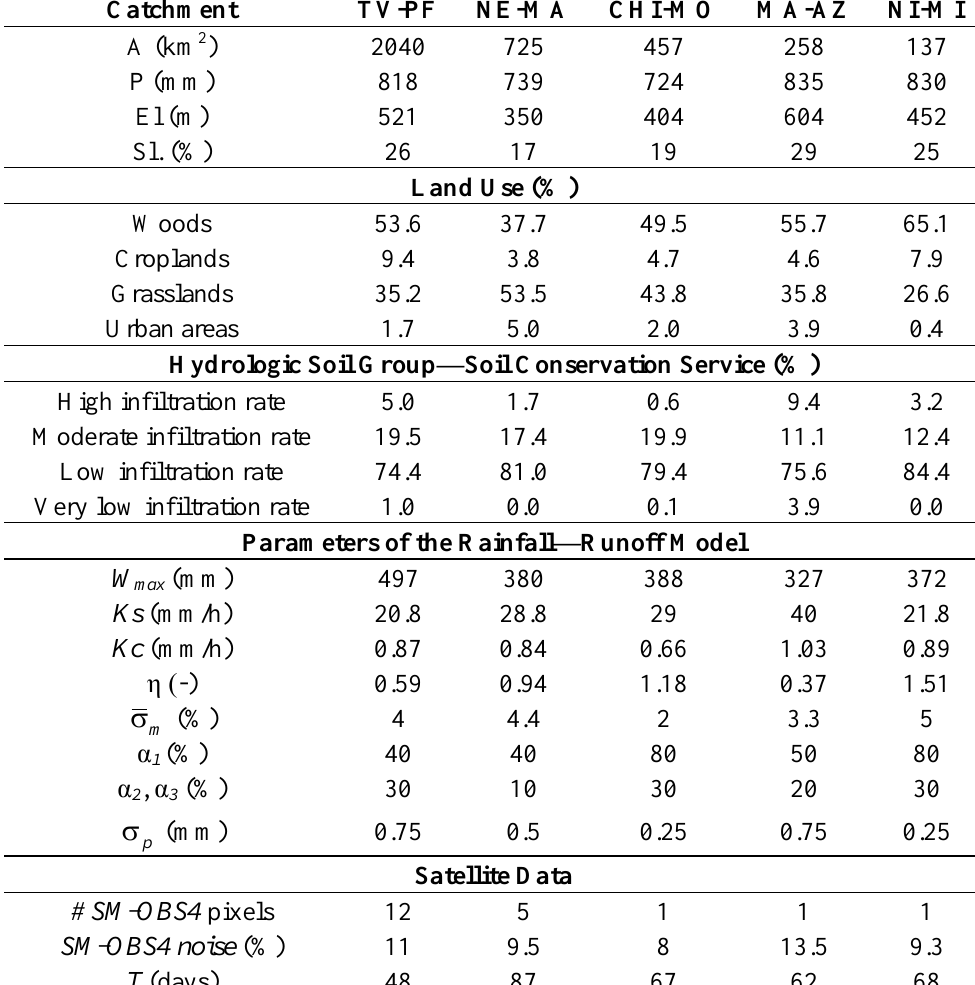
Table 1. Physical parameters of the selected catchments ( A = area, P = annual precipitation amount, El = mean elevation, Sl = mean slope) along with the most important calibrated model parameters in the period 2000–2009 ( W max = maximum water storage, K s = parameter of drainage, K c = parameter of evapotranspiration, η = lag time parameter of Equation (1))  # SM-OBS4 pixels represents the and the time averaged model error standard deviation m number of the satellite pixels falling inside the catchment area, SM-OBS4 noise is the spatial average of noise SM information provided as ancillary data with SM-OBS4 product while T refer to value of the characteristic time length of the Exponential filter. α 1 , α 2 , α 3 represent the coefficients used to multiply the value of the parameters for obtaining their model error standard deviation, while σ p is the rainfall error standard